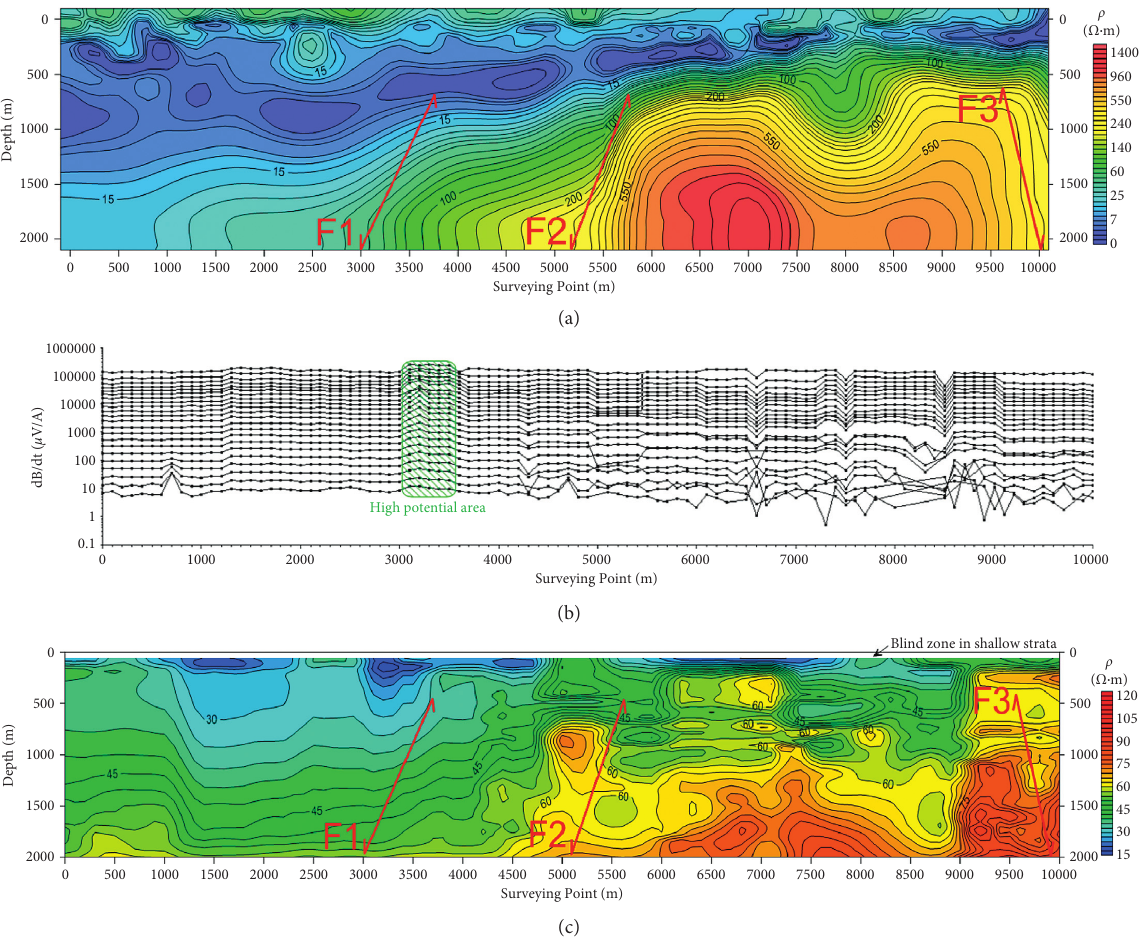
Figure 6: Contrast of CSAMTand TEM profiles of Line 60: (a). CSAMTresistivity profile, where the blue contours represent low resistivity, whereas the red contours represent high resistivity. (b). TEM secondary field profile, where the marked green area is the high potential area. (c). TEM resistivity profile, where the blue contours represent low resistivity, whereas the red contours represent high